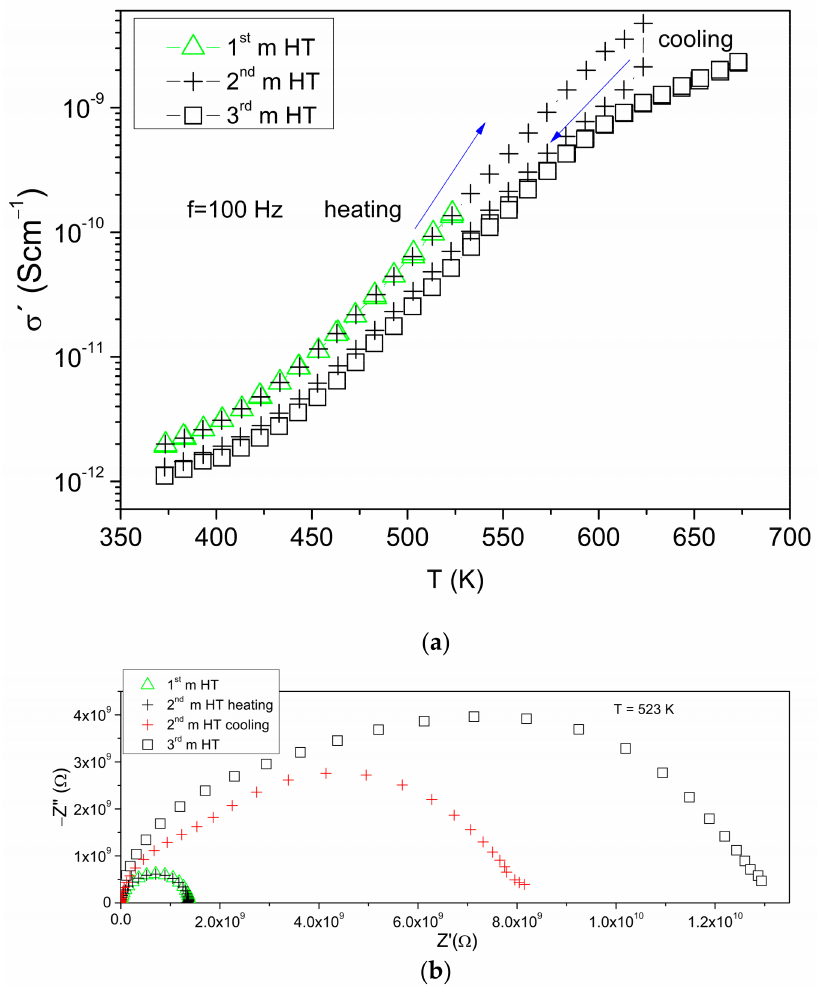
Figure 6. ( a ) The temperature dependence of the real part of the AC conductivity at a frequency of 100 Hz for: 1st m HT, 2nd m HT, and 3rd m HT measurements conducted under an air atmosphere for the 10 Mg sample. ( b ) The comparison of Nyquist plots at an exemplar temperature of 523 K for the 1st m HT, 2nd m HT cooling and heating, and 3rd m HT measurements.